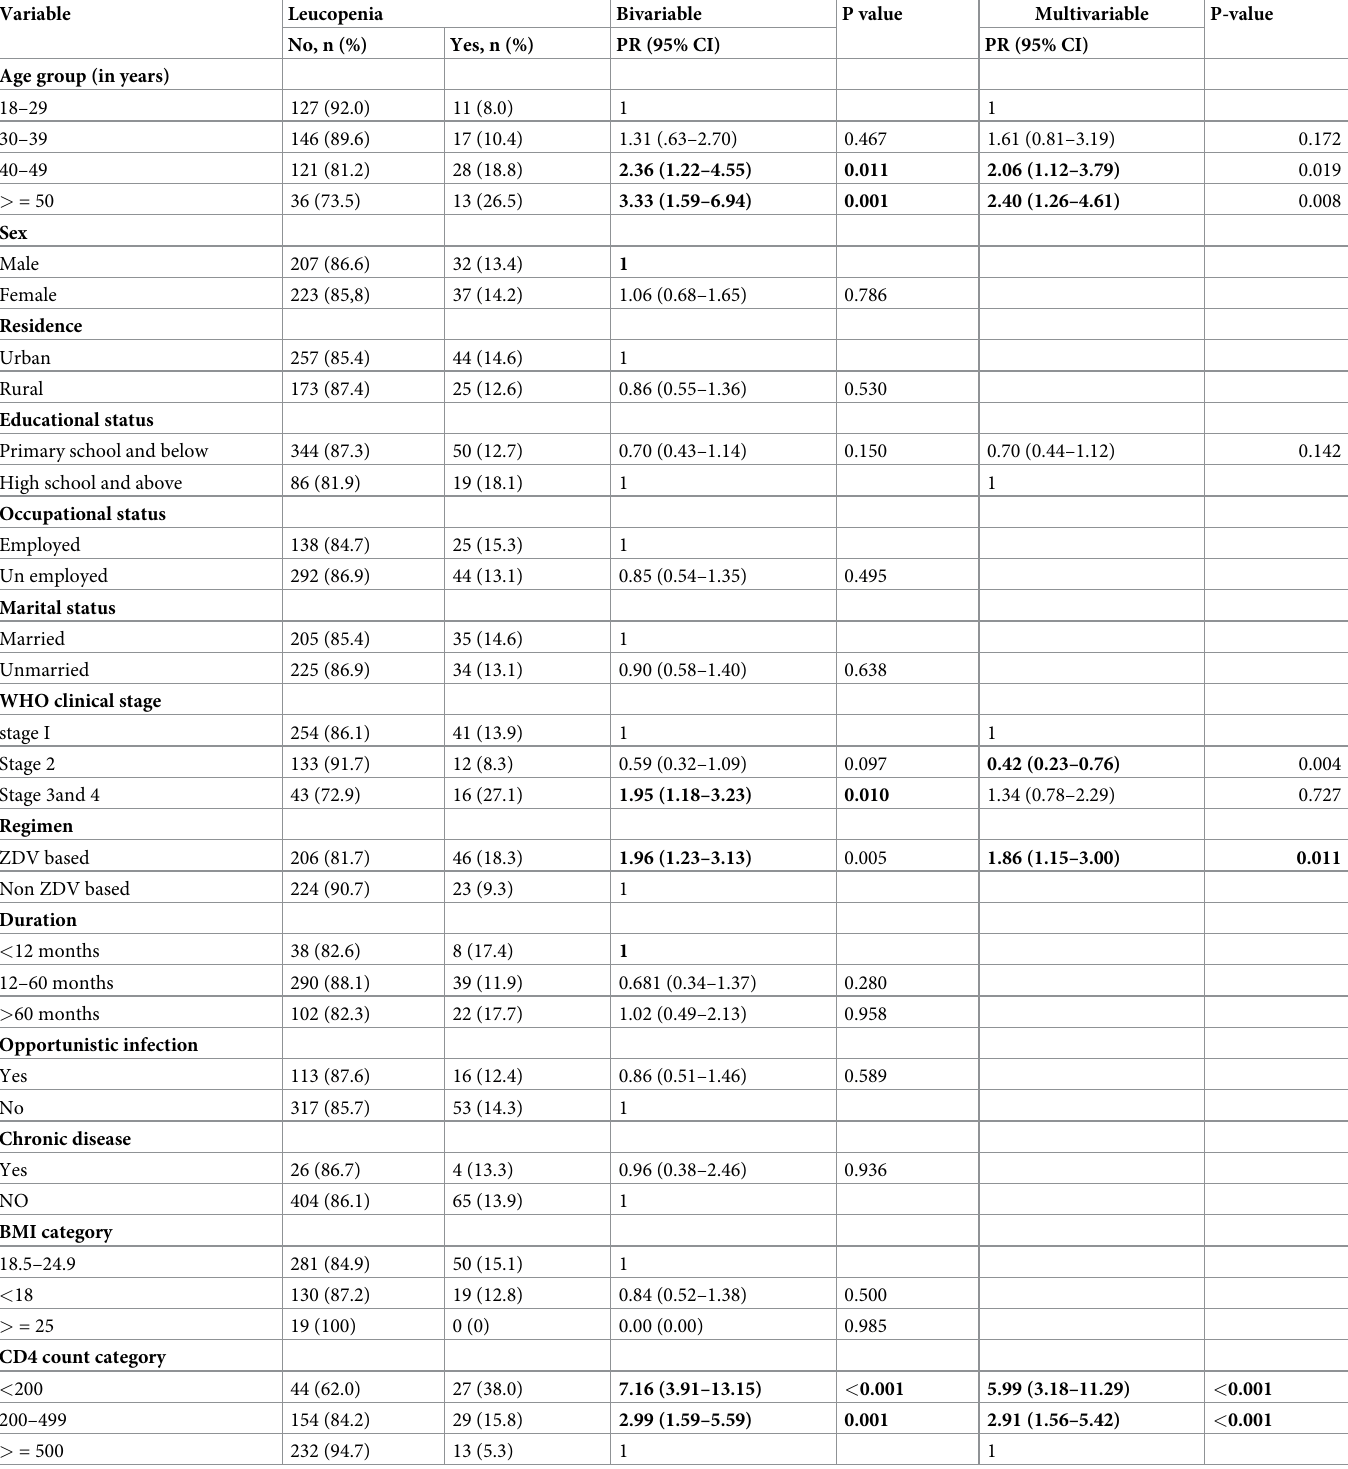
Table 6. Factors associated with leucopenia among HIV infected patients on HAART at Mahal-Meda Hospital, Northern Shewa Zone, Ethiopia, 2018 (n = 499).